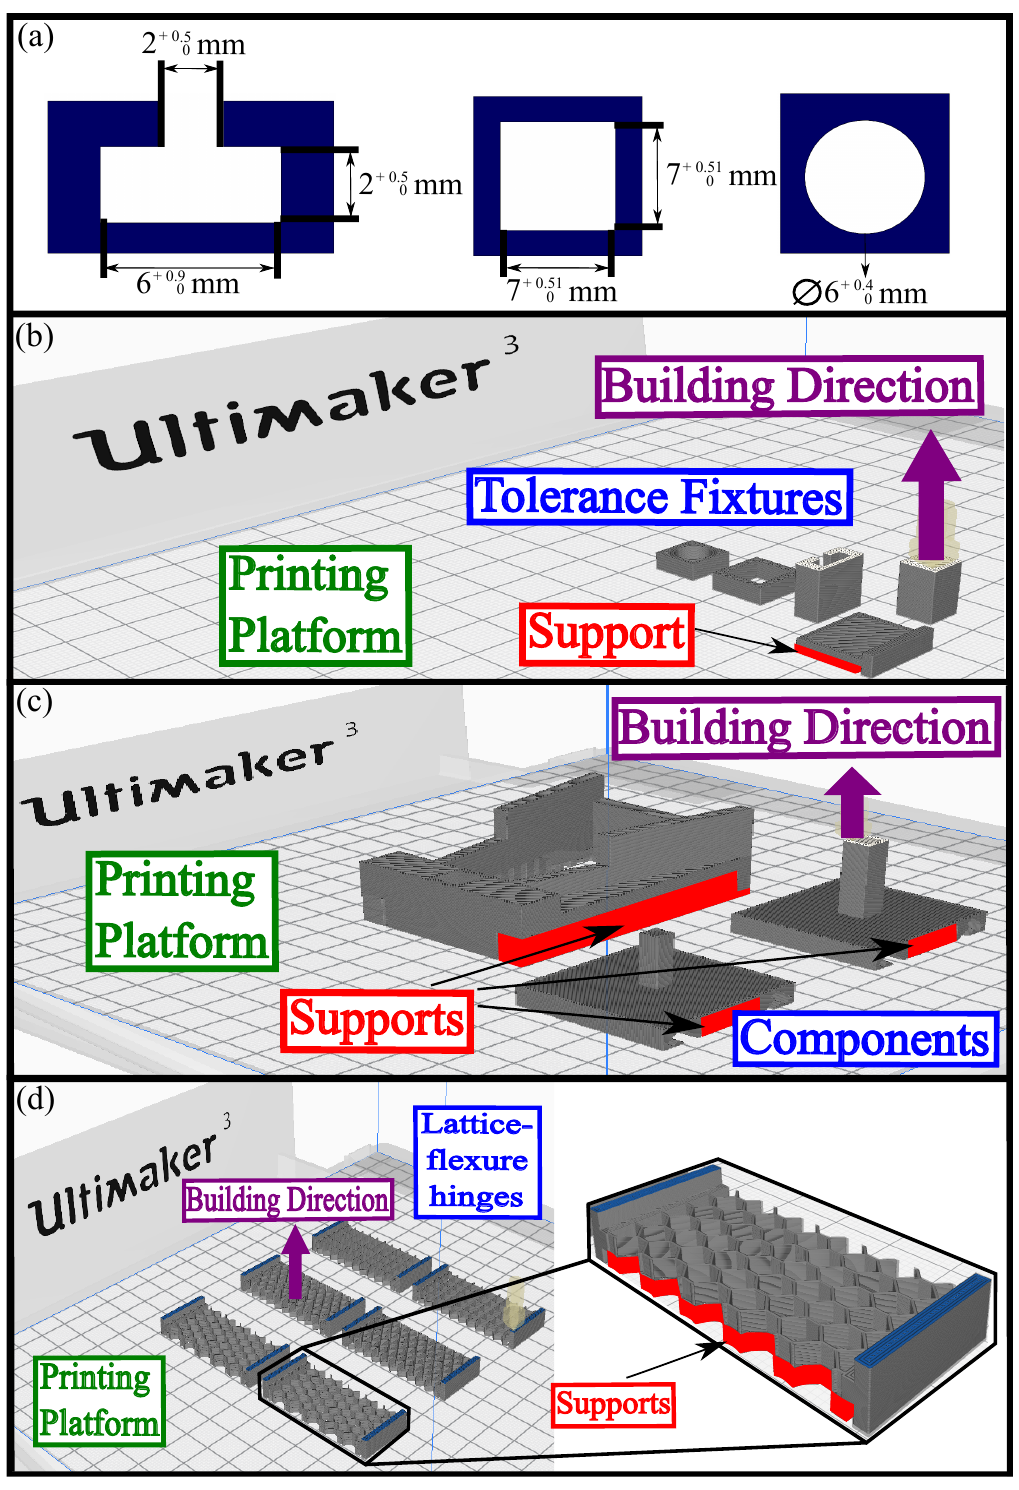
Figure 6. Calibration and pre-processing for the compliant cross-axis joint using the Cura ® envi- ronment. ( a ) Final tolerance dimensions from the “T” joint and the fixed add-in holes. ( b ) Isometric view of the “.stl” files of the tolerance fixtures. ( c ) Isometric views of the “.stl” files of the compliant cross-axis joint components. ( d ) Isometric view of the “.stl” files of some lattice-flexure